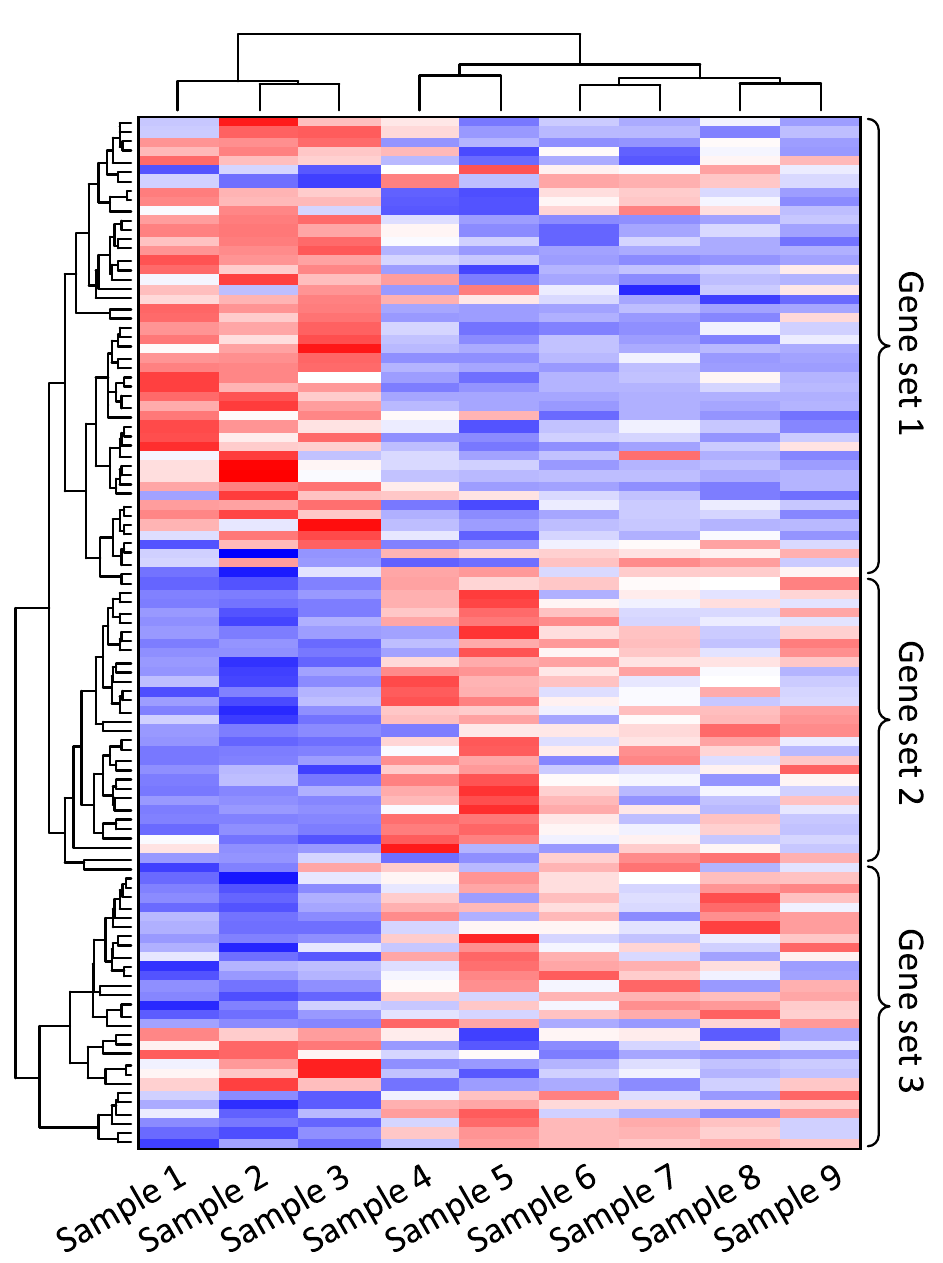
Fig 6. identification of gene co-expression patterns across different samples. Heatmap Each column containsthe measurements for gene expressionchangefor a single sample. Relativegene expressionis indicatedby colour: high-expression (red), median-expression (white) and low-expression (blue). Genes and samples with similar expressionprofilescan be automatically grouped(left and top trees). Samples may be different individuals, tissues, environments, or health conditions. In this example,expressionof gene set 1 is high and expressionof gene set 2 is low in samples 1, 2, and 3.